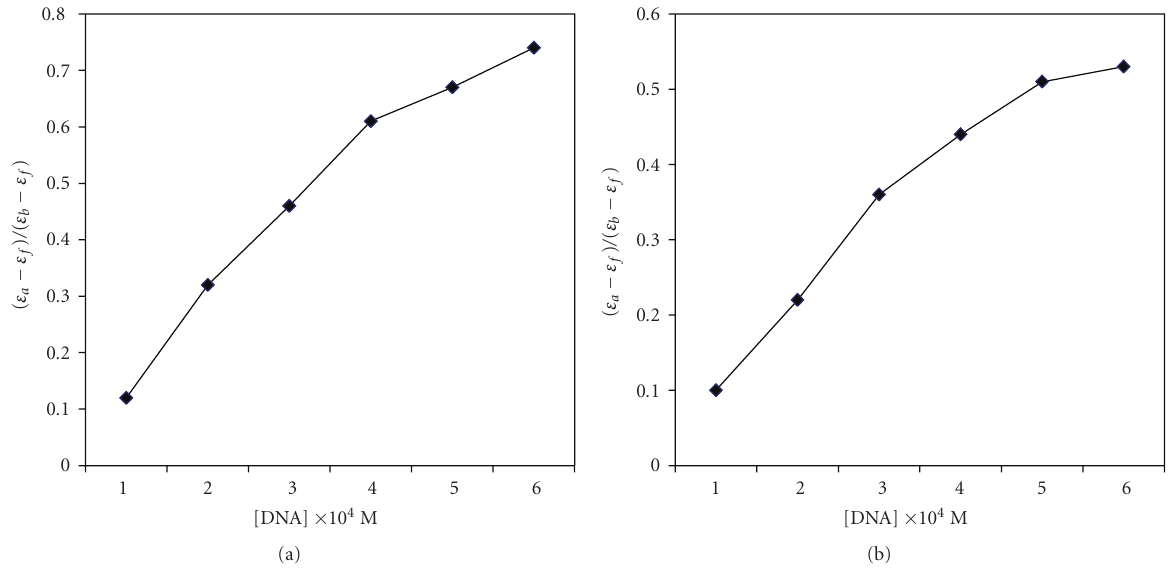
Figure 5: The plot of [DNA]/( ε a − ε f ) versus [DNA] for the titration of DNA with the complexes (a) 1 and (b) 3 .